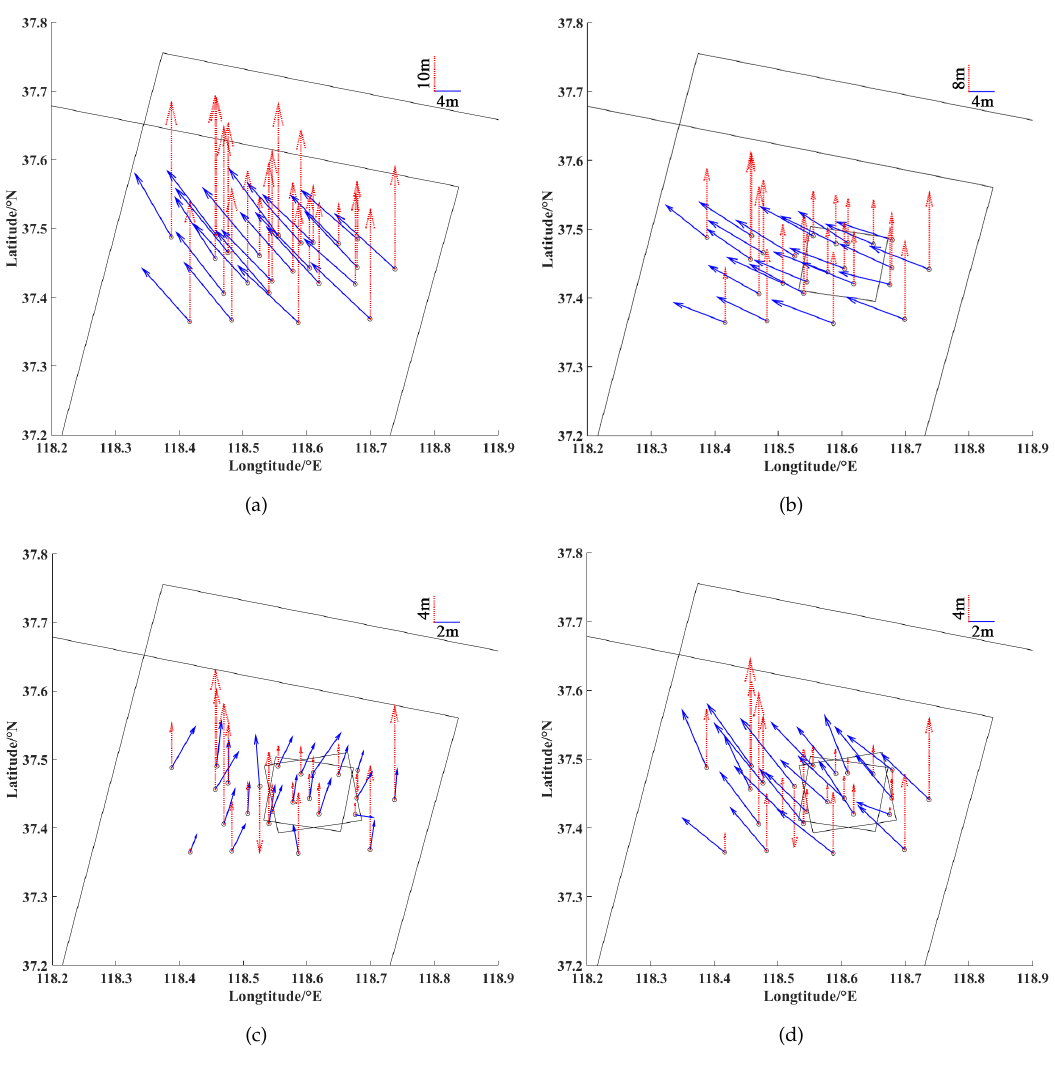
Figure 7. Geometric accuracy analysis of GF6 and GF3: ( a ) GF6 geopositioning, ( b ) GF6 + GF3-1 combined geopositioning, ( c ) GF6 + GF3-1 + GF3-2 combined geopositioning, and ( d ) GF6 + GF3-1 + GF3-2 combined geopositioning with the same